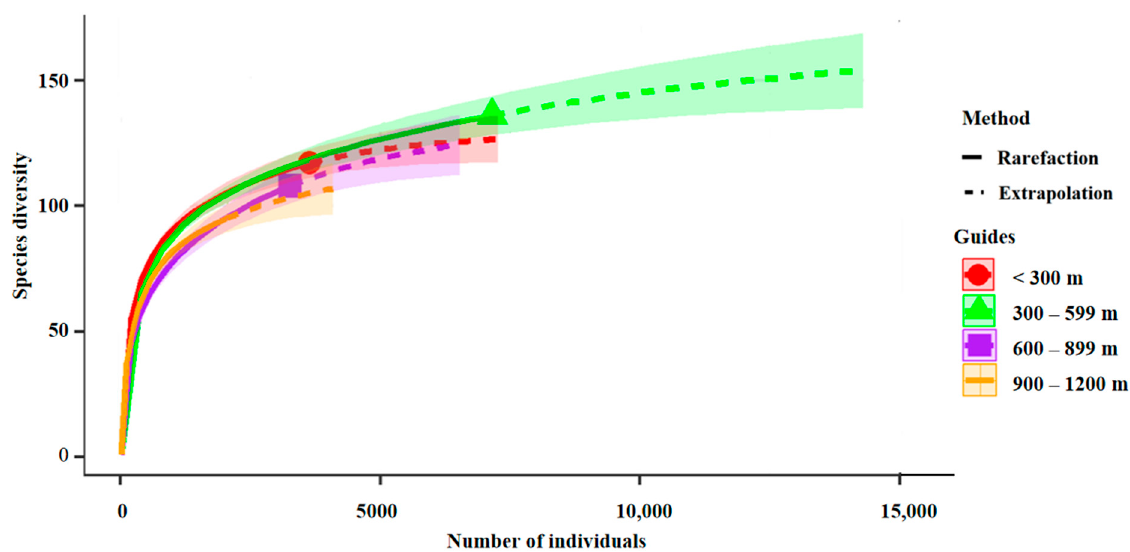
Figure 2. Sample completeness curves for bird communities in four altitude gradients.